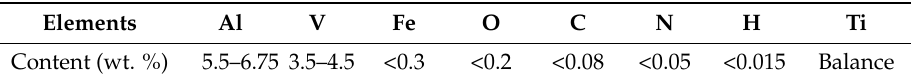
Table 1. Chemical compositions of used Ti–6Al–4V powder.